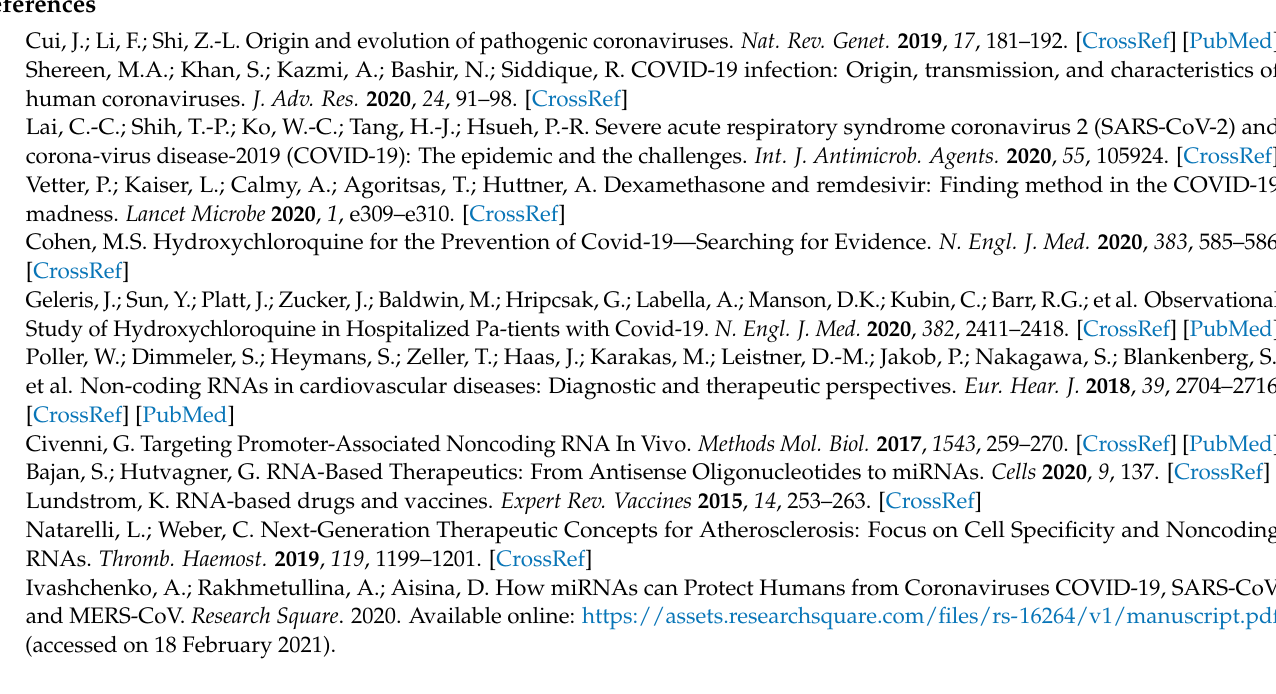
Table S6: SARS-CoV-2 consensus motifs identified at the 5 (cid:48) UTR leader sequence, Supplementary Table S9: Role of miRNA candidates against Spike transcript and the 3 (cid:48) UTR of SARS-CoV-2, Supple- mentary Figure S1. Schematic workflow for the entire study including the parameters/threshold used at each step, Supplementary Figure S2. Distribution of the differential expression values of genes targeted by the miRNAs targeting the leader sequence of the SARS-CoV-2, Supplementary Figure S3. GGG motif and leader motifs from selected miRNA candidates interacting with the leader sequence of